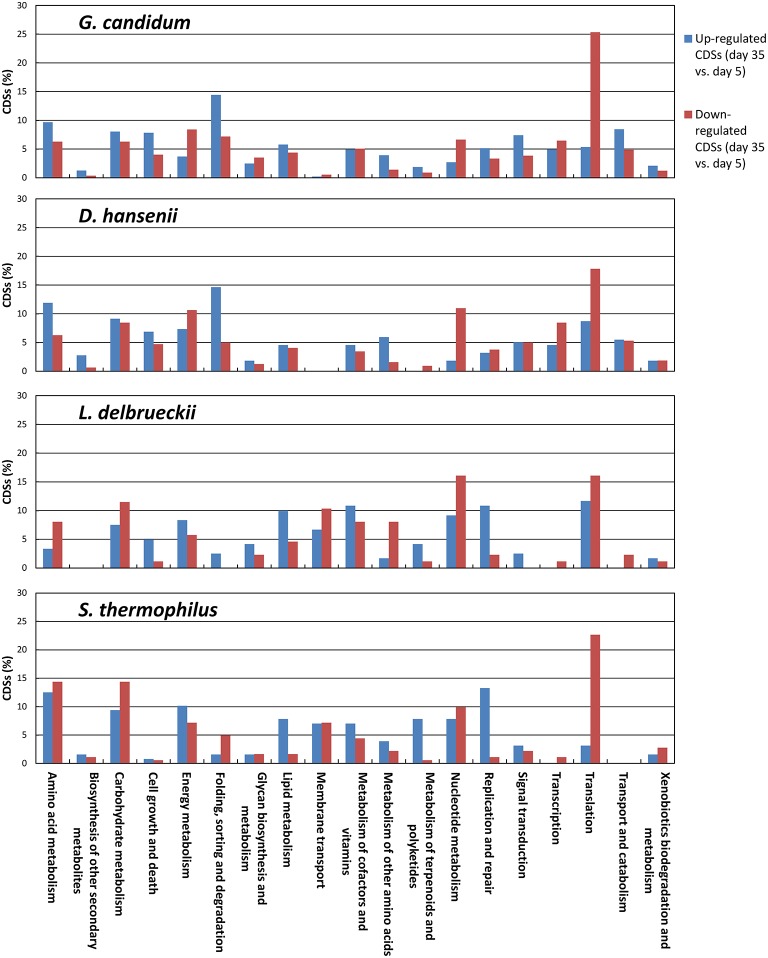
Functional classification of the CDSs that were differentially expressed at day 35 in comparison to day 5. Differential expression was evaluated using the DESeq2 package. For each species, results are represented as percentages relative to the sum of the KEGG entries generated from the up- or down-regulated genes.